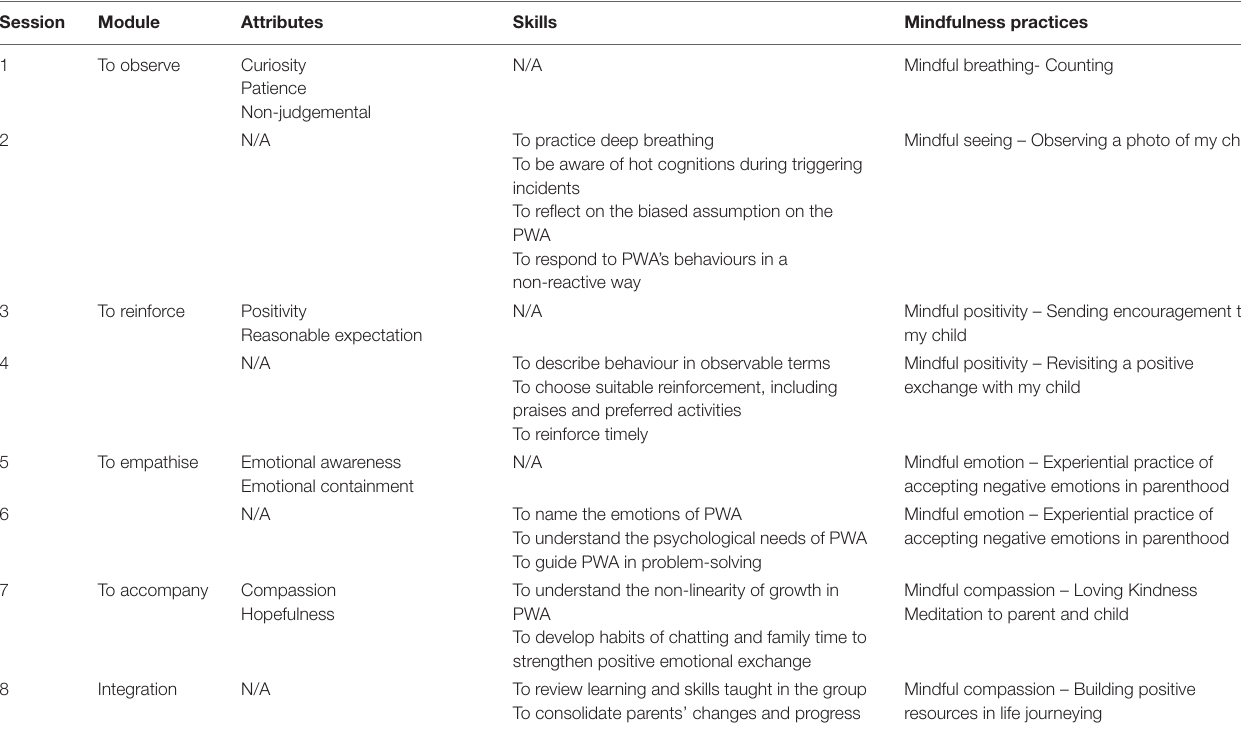
TABLE 2 | Session outline of the